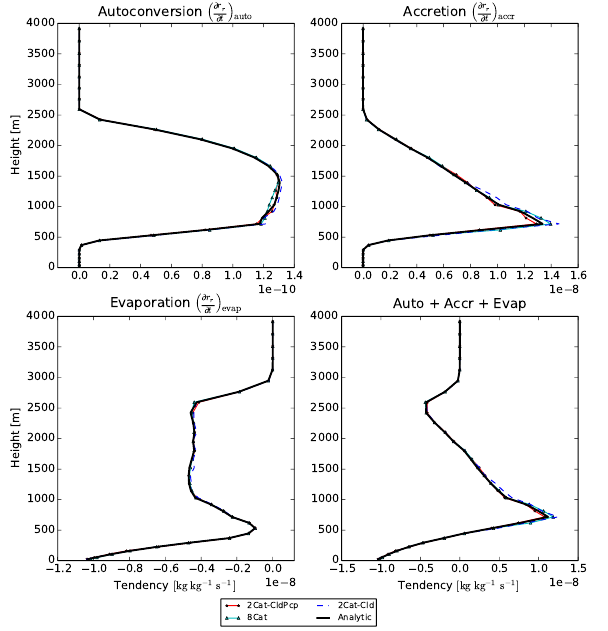
Figure 4. RICO: profile RMSE plots of the four tendencies. The simulations in these plots use 32 sample points. For each configu- ration, an ensemble of 12 simulations is used, each with a different seed. RMSE values are averaged over all 864 timesteps of the sim- ulation and all 12 ensemble members. The 8Cat and 2Cat-CldPcp methods show improvement between 1000m and 2500m, where the improvement in sampling of the evaporation term is largest. All three methods suffer from extra noise below 1000m, which is far away from the importance sampling level. The importance sampling level is just under 2000m for most timesteps in the